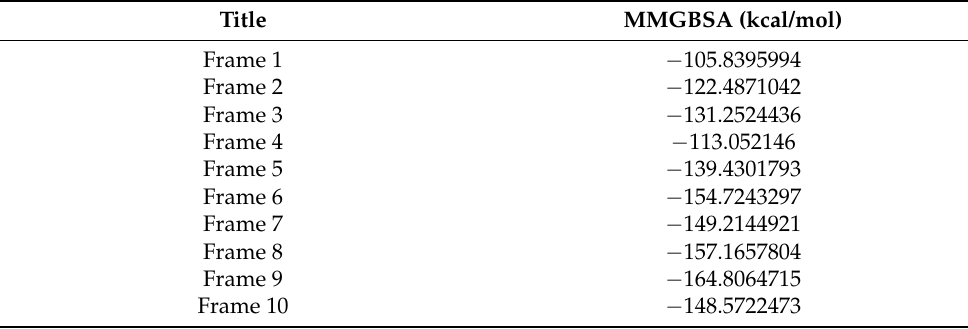
Figure 7. Histogram plot of beta-sitasterol in complex with 6IE9: X -axis depicts interactive amino acids and Y -axis reveals interaction fractions. (Gray color indicates Hydrophobic interactions, Blue color indicates water bridges and Green color indicates Hydrogen bonding). Table 5. Thermodynamic binding energy of Beta-sitasterol in complex with 6IE9.